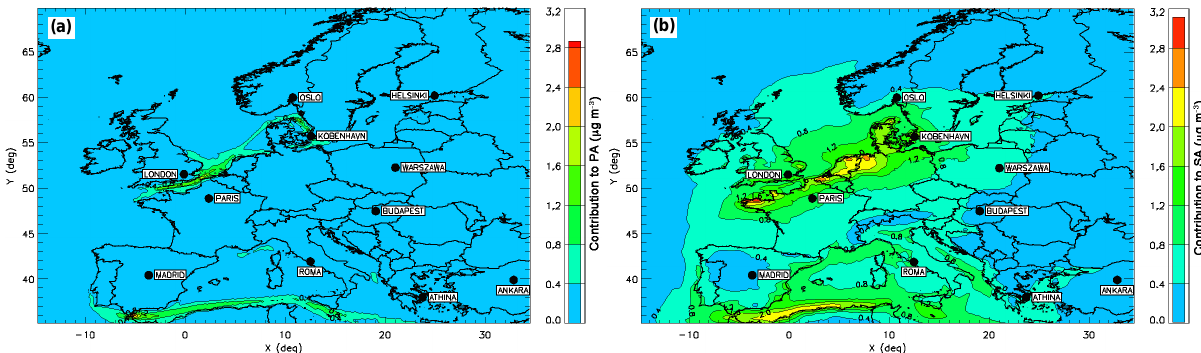
Figure 5. Contribution of ship emissions (µgm − 3 ) to (a) the primary aerosol (PA) and (b) the secondary aerosol (SA) concentration in summer 2006 (base case − no